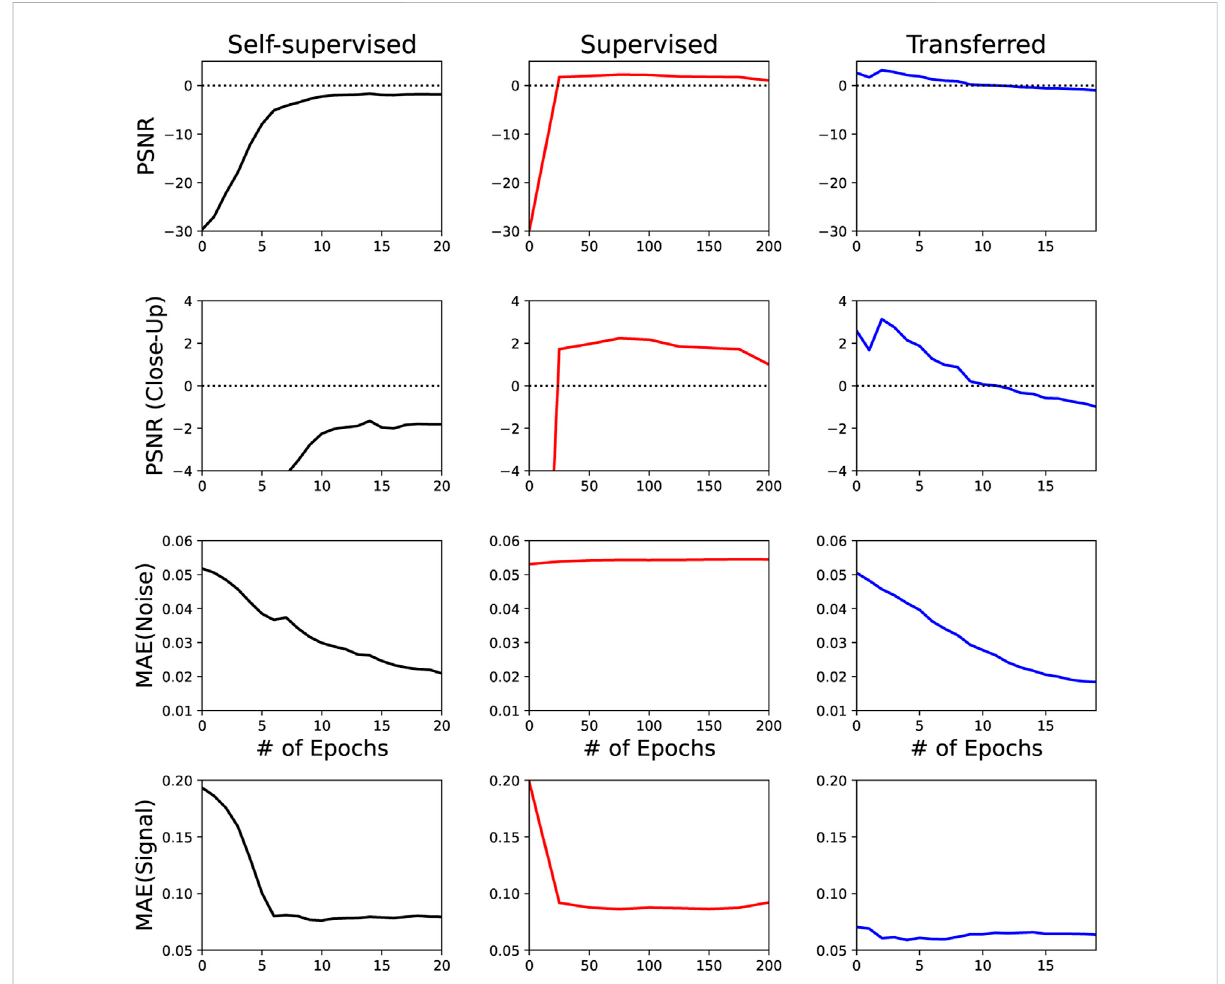
FIGURE 5 Denoising performance with respect to epochs for self-supervised (left), supervised (center) and fi ne-tuned (right) networks. The top two rows illustratethePSNRchangethroughdenoisingwithdifferenty-axesscalesforcomparison,thethirdillustratesthenoisesuppressedwhilstthebottom row illustrates the volume of signal leakage